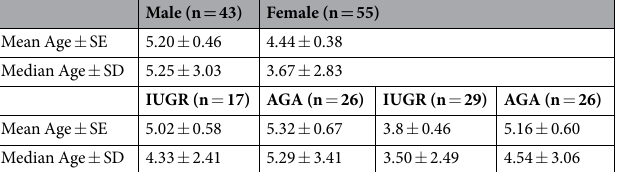
Table 1. Comparison of age between male and female children born IUGR and AGA at the observation time. Statistical comparisons were performed with multiple factors ANOVA followed by an LSD post-hoc test for the means and a non-parametric median test for the medians. Neither analysis revealed any statistical differences among the